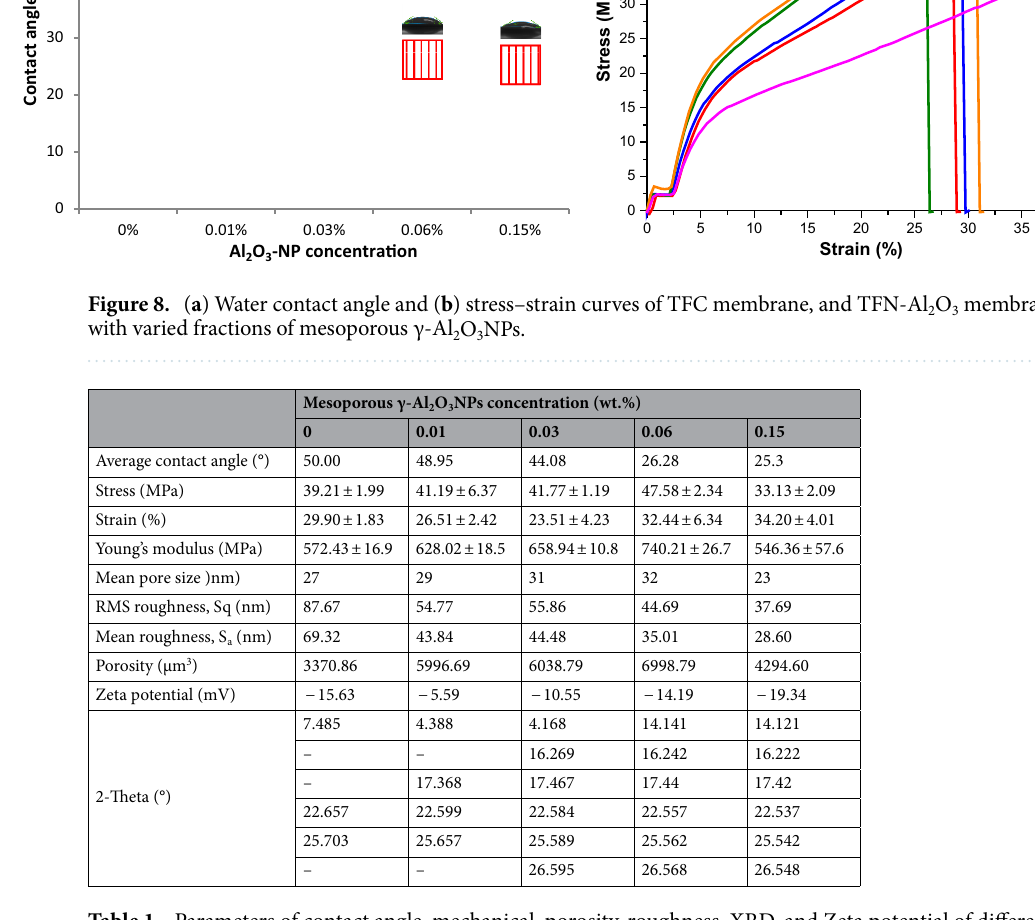
Table 1. Parameters of contact angle, mechanical, porosity, roughness, XRD, and Zeta potential of different fabricated TFN membranes.